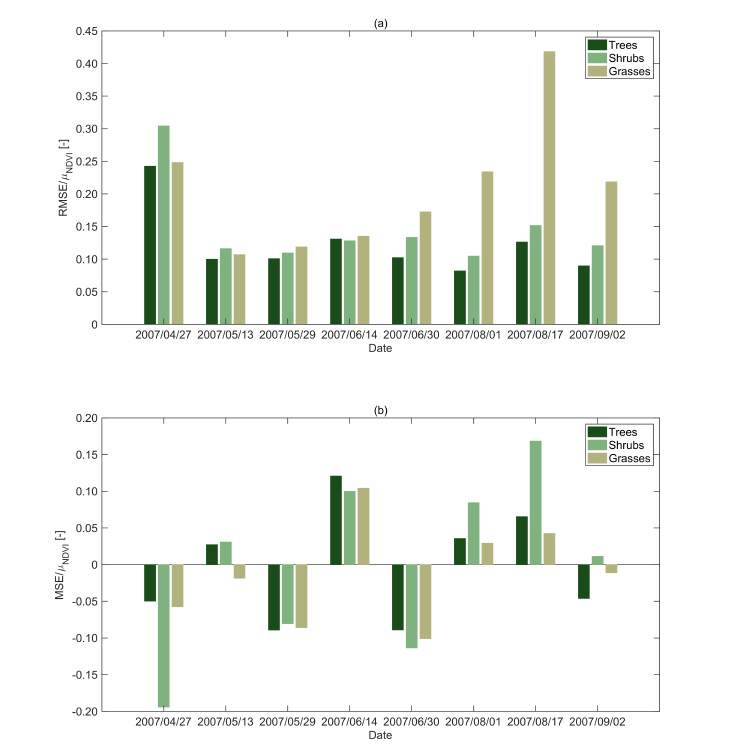
Figure 4. Normalized root mean square error ( RMSE / µ NDVI ) ( a ) and normalized mean signed error ( MSE / µ NDVI ), ( b ) separated by dominant vegetation functional type over the 2007 growing season at Dry Creek Experimental Watershed (DCEW), Idaho, USA. Errors were normalized by dividing RMSE and MSE by the mean normalized difference vegetation index (NDVI) for the given vegetation functional type on the given date (see Table 1).